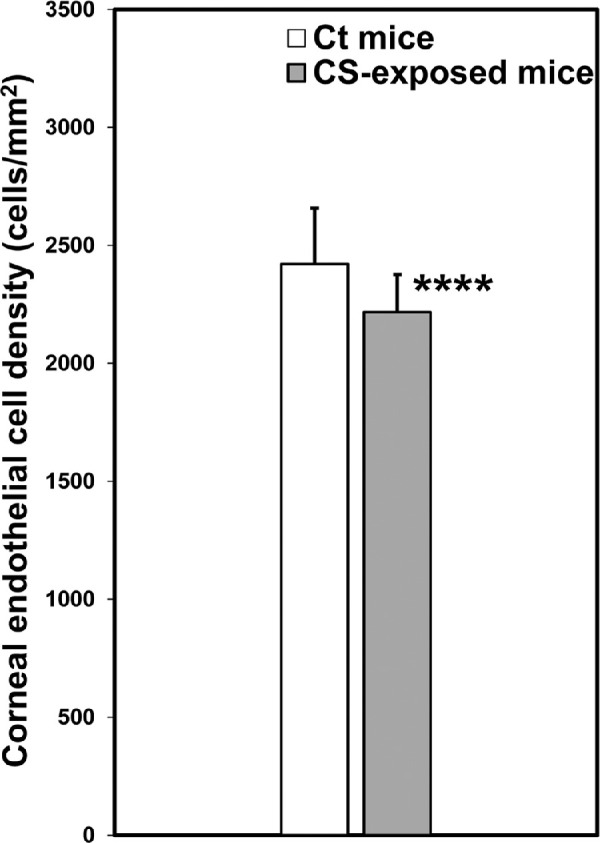
Evaluation of corneal endothelial cell (CEC) density in cigarette smoke-exposed (CS-exposed) and control (Ct) mice corneal endothelium (CE). The analysis shows a bilateral decrease in CEC density in CS-exposed mice compared with Ct mice. ****P < 3.0e−05 (two-tailed Student's t-test).